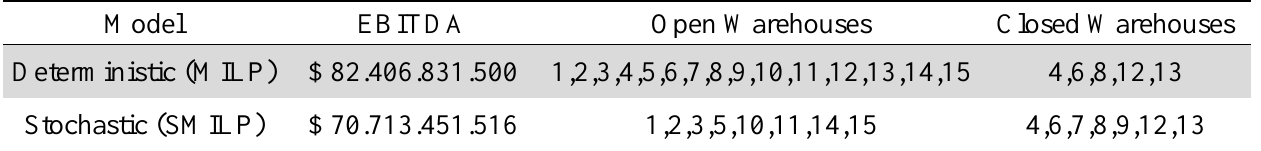
Comparison of deterministic and stochastic